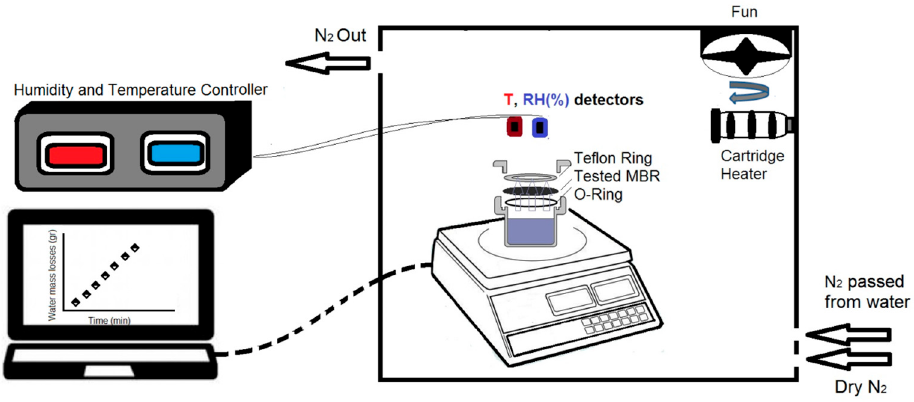
Figure 2. Homemade experimental setup used for water vapor transmission rate (WVTR) measurements.